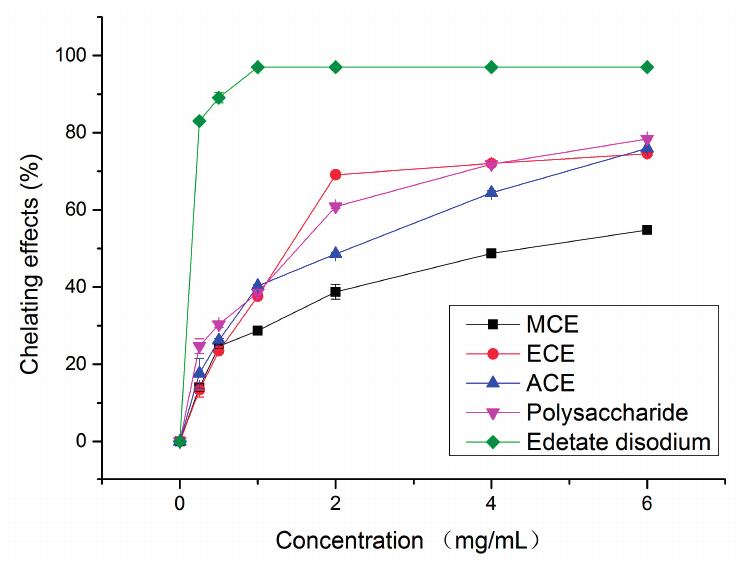
Figure 3. Metal chelating effects of different concentrations of four extracts and edetate disodium on ferrous ions. MCE: methanolic crude extract; ECE: ethanolic crude extract; ACE: aqueous crude